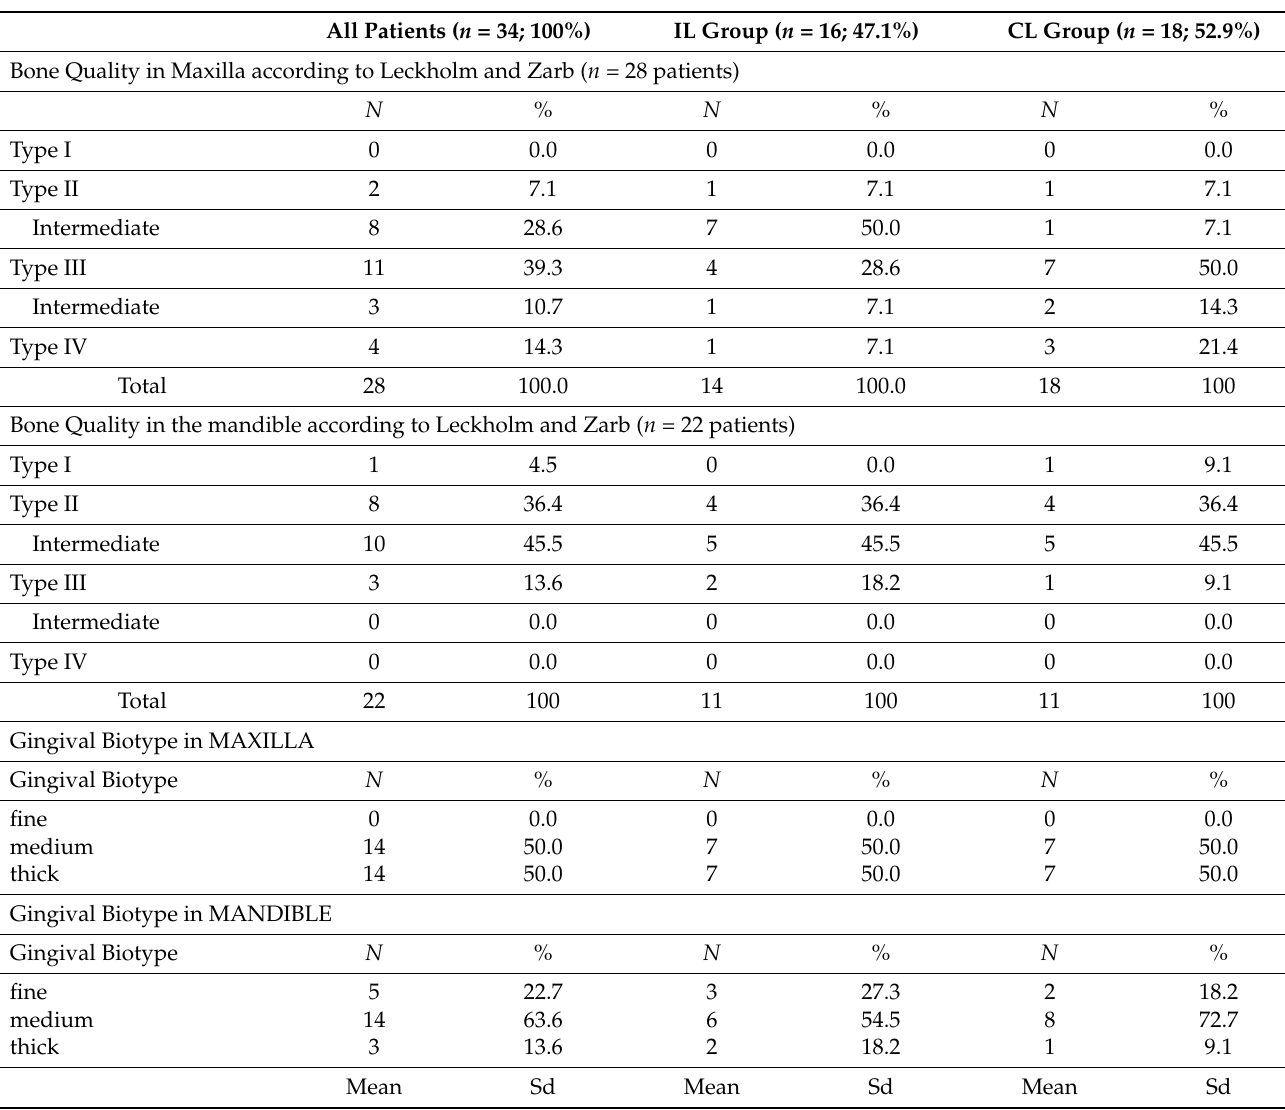
Table 2. Anatomical conditions of the jaws of the study sample ( n = 34) at baseline. Comparisons by Chi Square and Student t -tests.